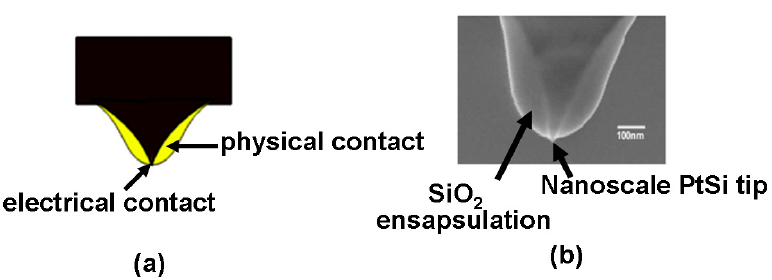
Figure 6. ( a ) Schematic of the ‘encapsulated’ tip concept, and ( b ) the experimentally fabricated encapsulated tip. Reproduced with permission from [24]. Copyright IOP Science, 2009.